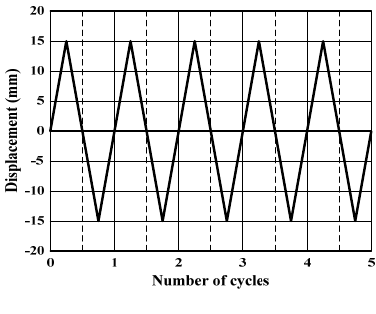
Figure 4. Shear force versus displacement curve of tested specimens: ( a ) SD1; ( b ) SD2; ( c ) SD3.